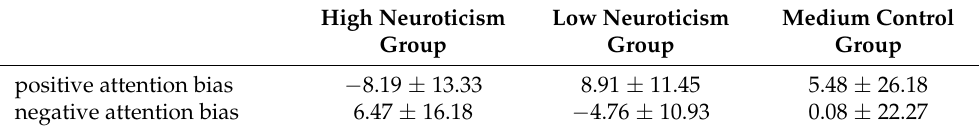
Table 5. Descriptive statistics of positive and negative attention biases. ( M ± SD ; Unit: ms).